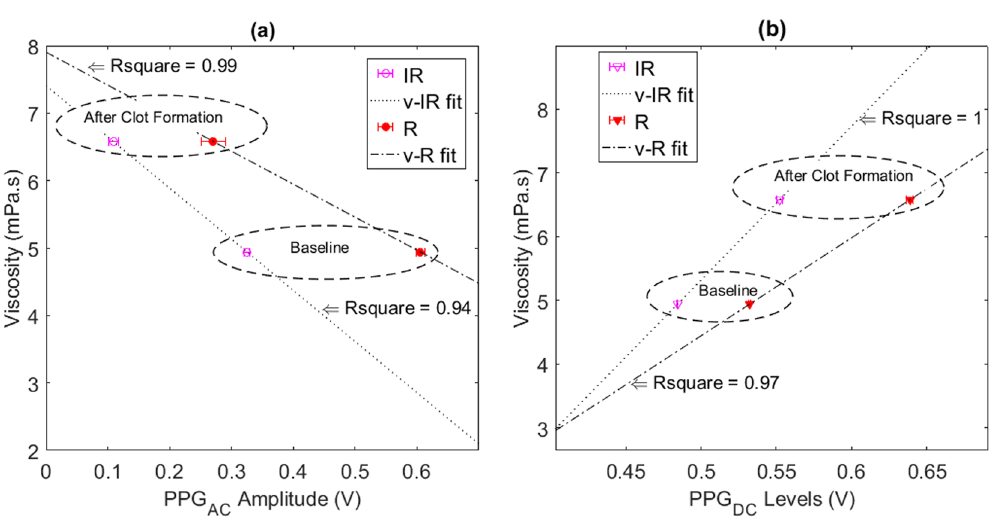
Figure 8. Regression models relating measured viscosity values with PPG components. Models created for R and IR PPG signals from the in vitro experimental setup before and after clot formation at a frequency of 1 Hz and a stroke volume of 70 ml. ( a ) Linear regression model for viscosity values (v) versus the amplitudes of PPG AC at both wavelengths. ( b ) Linear regression model for viscosity values (v) versus levels of PPG DC at both